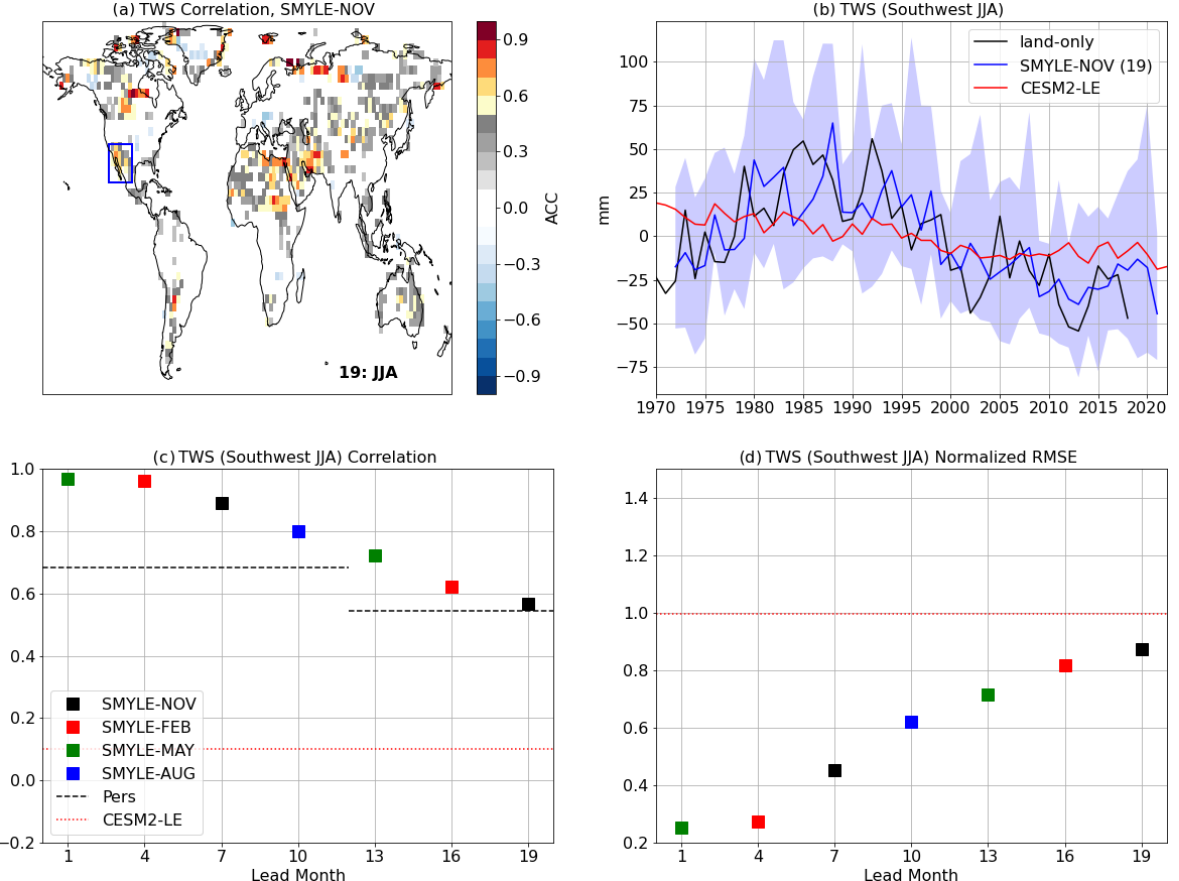
Figure 10. (a) ACC for terrestrial water storage (TWS) in boreal summer (JJA) at lead month 19 (from SMYLE-NOV). The blue box (22– 37 ◦ N, 120–100 ◦ W) defines a “southwest” region. (b) Time series of raw southwest JJA TWS (in units of mm; anomalies from 1972–2018 climatology) from land-only simulation (black), SMYLE-NOV (blue; lead month 19 with ensemble mean/range given by line/shading), and CESM2-LE (red; 50-member mean). (c, d) ACC and nRMSE scores for JJA TWS over the southwest region. Time series were detrended prior to skill score analyses shown in panels (a) , (c) , and (d) , but panel (b) shows the non-detrended data. Dashed lines in panel (c) show skill for persistence forecasts computed from the lag autocorrelation of detrended JJA TWS from the land-only simulation, and red dotted lines in panels (c) and (d) give the CESM2-LE scores (which are independent of lead